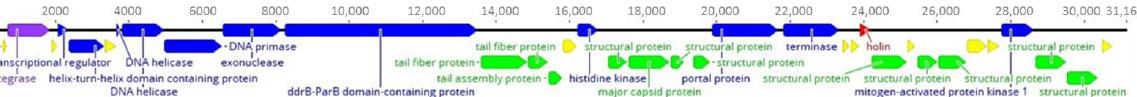
Figure 2. Genome overview of the Helicobacter phage HPy1R. Genome map with the predicted 36 CDSs numbered and coloured (blue shows DNA replication and transcription genes, green represents DNA packaging and phage morphogenesis genes, red indicates cells lysis genes, purple indicates integration genes, and yellow shows hypothetical proteins) according to their predicted function. Some important CDSs are highlighted. The nucleotide position (in kb) is indicated above the genome. The figure was generated using Geneious 9.1.4.